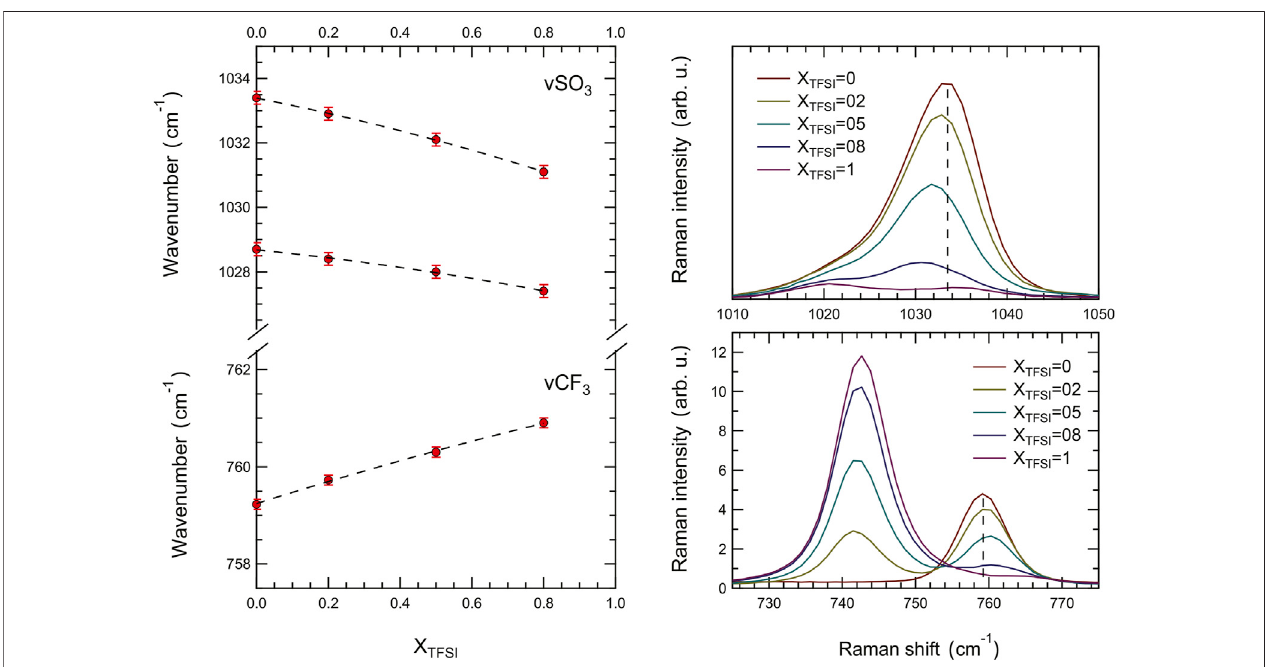
FIGURE 8 | Composition dependence of the Raman frequency shift of the symmetric S-O and C-F stretching modes in the TfO anion.